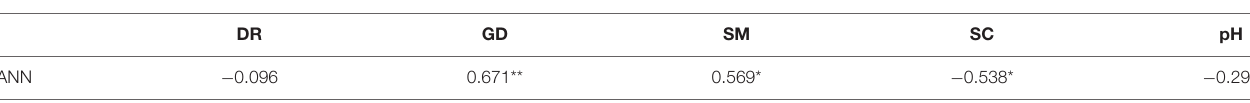
FIGURE 7 | Spatial pattern index, GD, and SM at all transects. ANN is the nearest neighbor index; GD is the groundwater depth; SM is the soil moisture; R is the correlation coefficient; * represents significant correlation ( P < 0.05). On X-axis the U1–U6, M1–M6, and L1–L6 represented the upper, middle, and lower reaches plots. TABLE 4 | Correlation values between ANN and abiotic